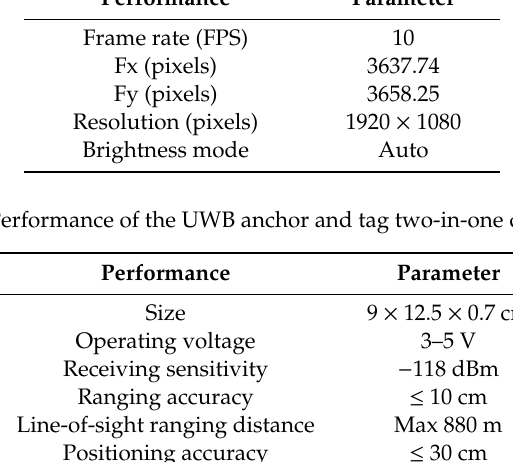
Figure 4. Experiment devices. ( a ) Camera; ( b ) ultra ‐ wideband (UWB) anchor and tag two ‐ in ‐ one device. Table 1. Performance of the camera. Table 1. Performance of the camera.